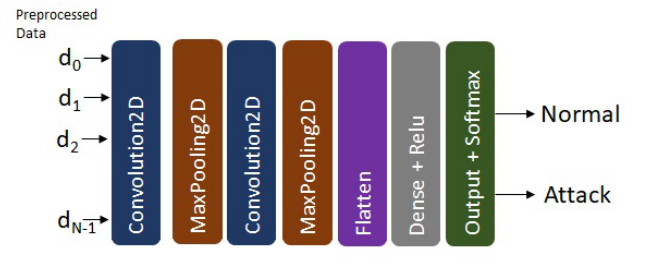
Figure 3. CNN-based IDS-model structure.